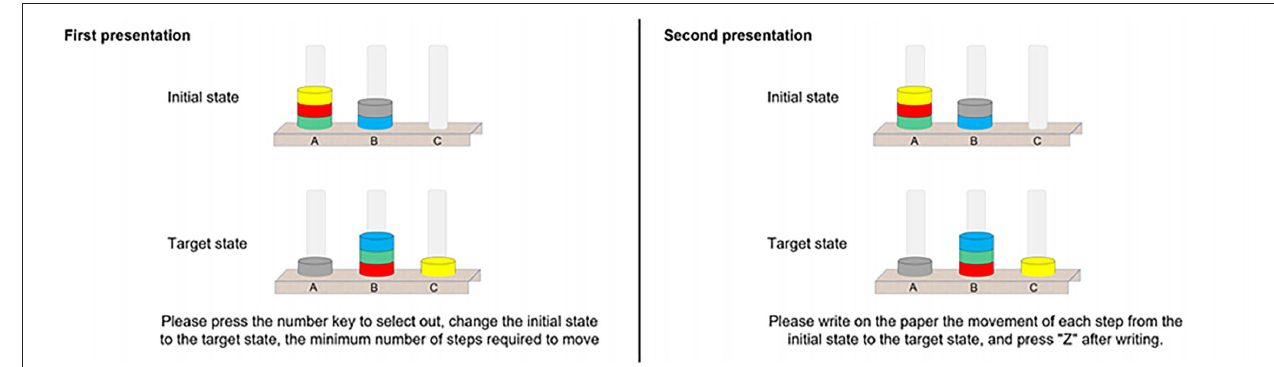
FIGURE 2 | An example Tower of London Task presented on the computer screen, with the first presentation on the left and the second presentation on the right, with a minimum of seven moves.